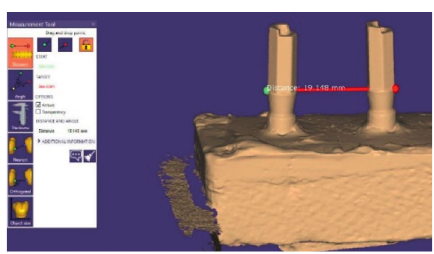
Figure 6: The designed image in CAD